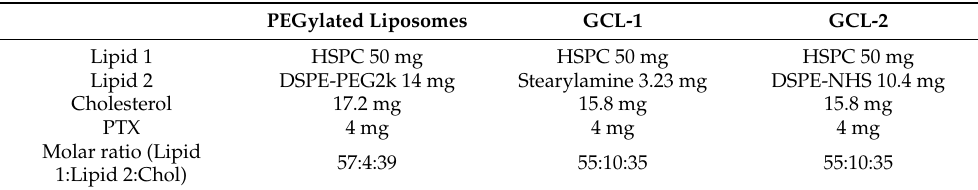
Table 1. Formulations of liposomes. Lipid 1 refers to HSPC, and lipid 2 refers to DSPE-PEG2k or Stearylamine or